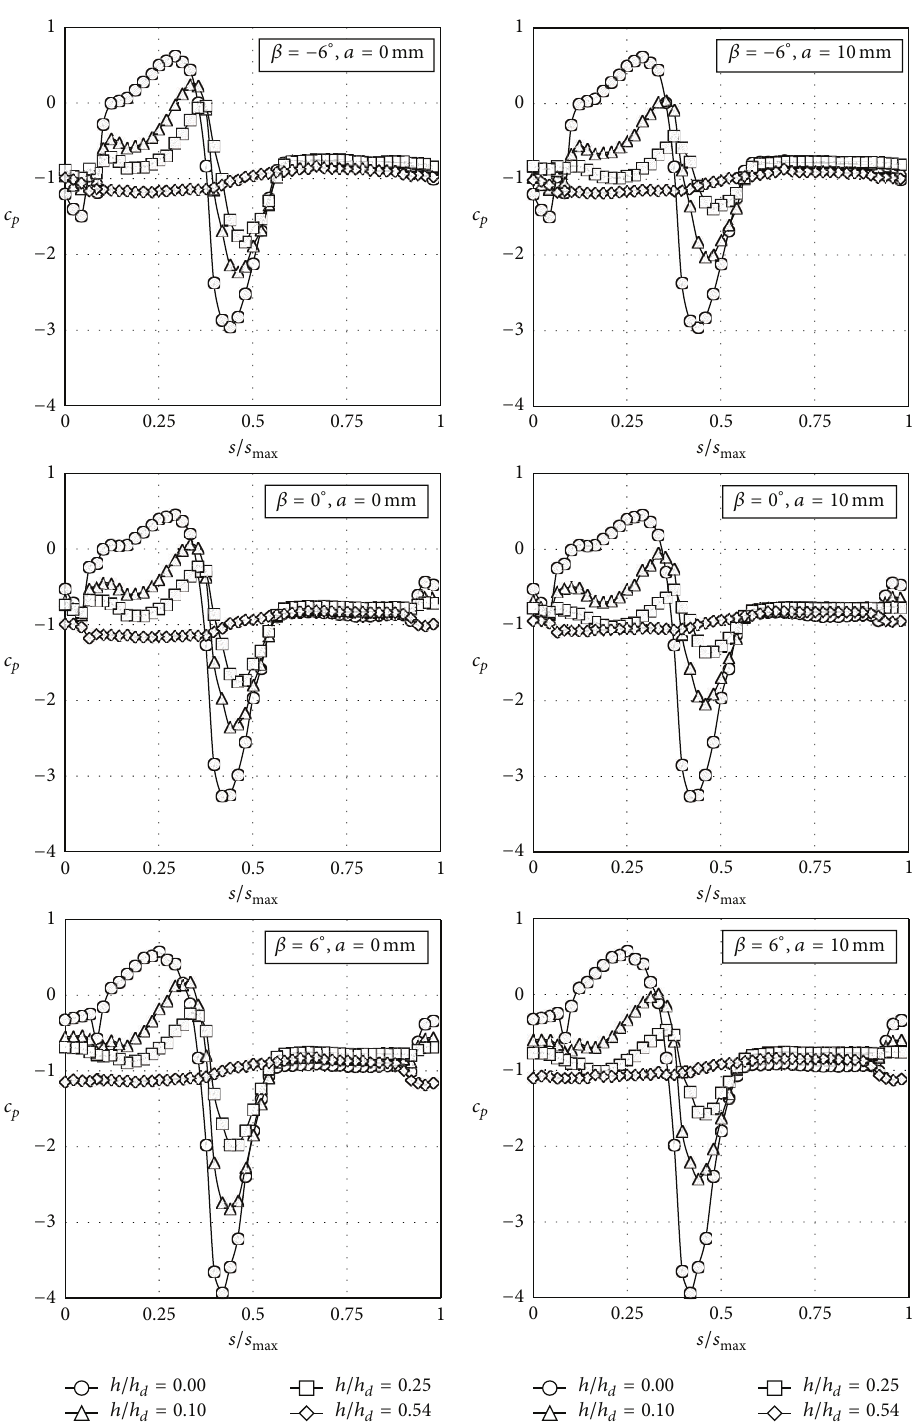
Figure 8: Pressure coefficient, 𝑐 𝑝 , distributions with the coach placed on the leeward railway track on an embankment with a slope 1:2, as a function of the nondimensional distance over the train surface at the middle cross-section, 𝑠/𝑠 max (see Figure 4(b)).